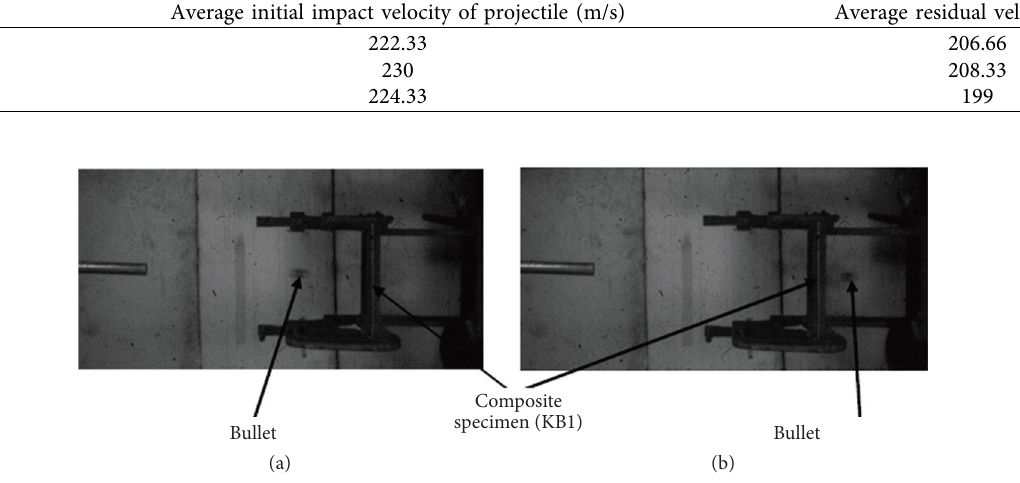
Figure 7: KB1 placed for testing: (a) KB1 before the impact and (b) KB1 bullet after the impact.